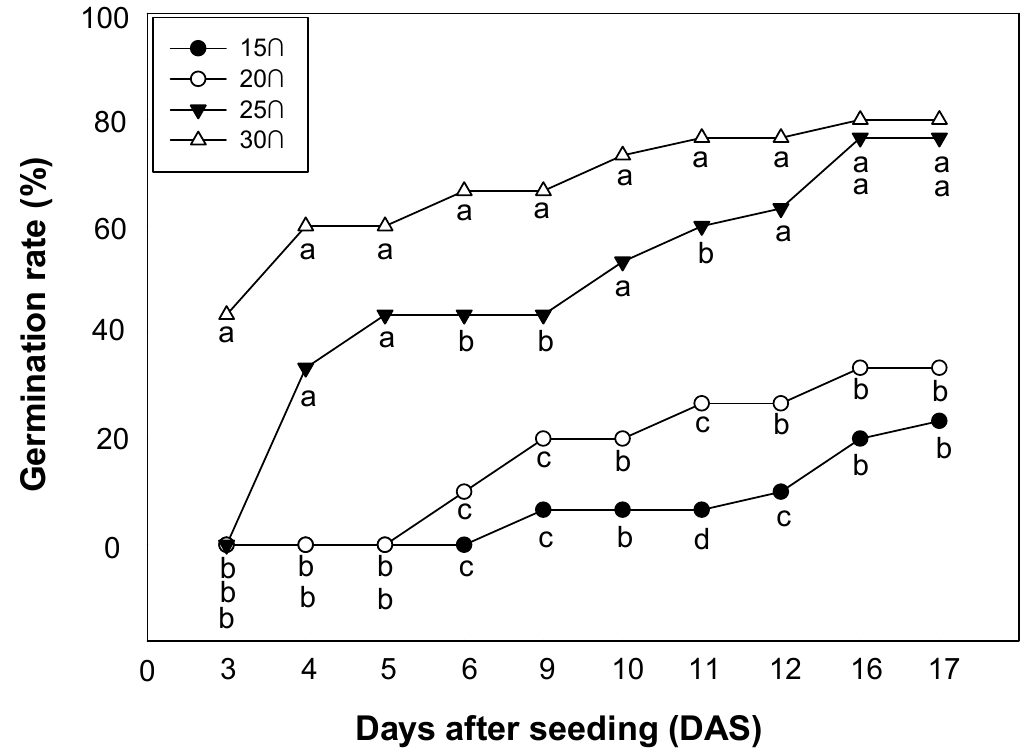
Days after seeding (DAS) Figure 2. Germination rate (%) of A. patulus grown at different temperatures in growth chambers. Means within a figure followed by the same letters are not significantly different at the 5% level according to Duncan’s Multiple Range Test.